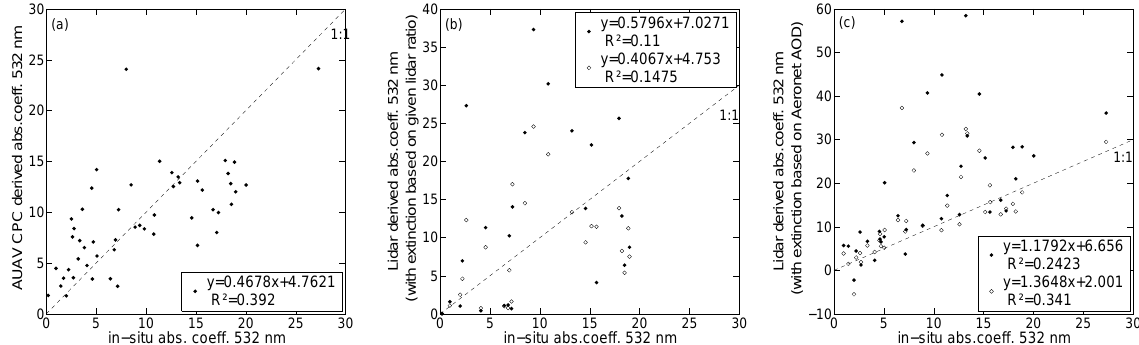
Figure 8. Scatter plot of (a) AUAV CPC derived absorption and in situ absorption coefficients, (b) Lidar-derived absorption coefficients with extinction coefficients based on a given lidar ratio depending on air mass source region and source-specific SSA (closed circles) or actual SSA (open circles) against the in situ absorption coefficients and (c) Lidar-derived absorption coefficients with extinction coefficients constrained by the AERONET AOD and source-specific SSA (closed circles) or actual SSA (open circles) against the in situ absorption coefficients. Particle absorption coefficients are given for 532nm.